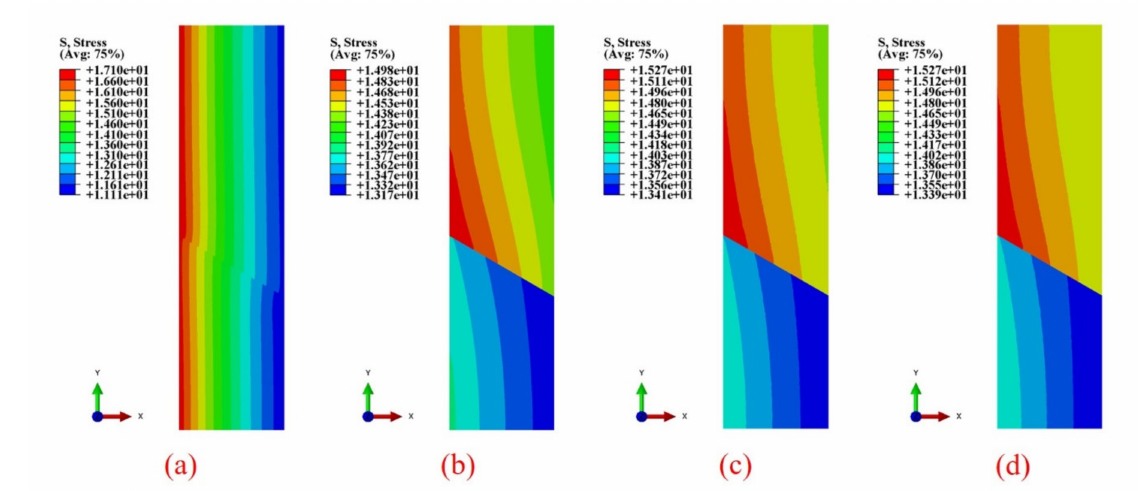
Figure 13. Mises stress distribution of the fresh-to-aged welded joint at ( a ) 0, ( b ) 1 × 10 4 , ( c ) 1 × 10 5 , and ( d ) 1.5 × 10 5 h.